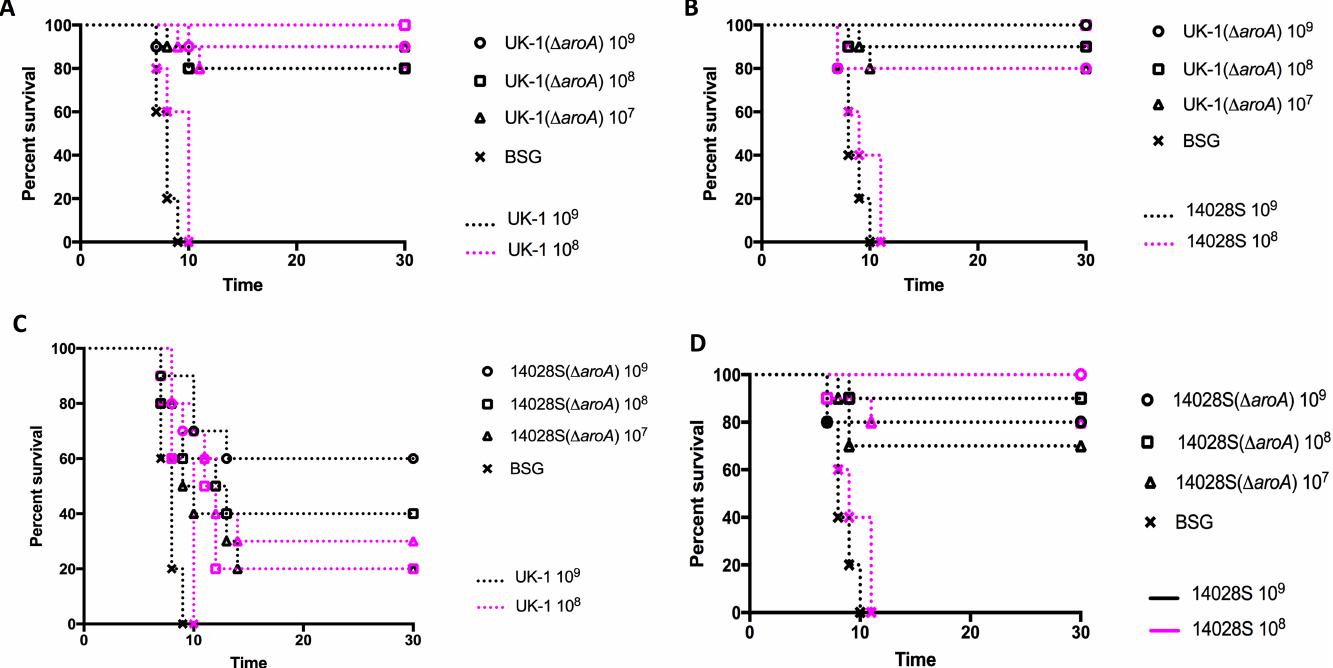
Fig 1. Protective efficacy of Δ aroA mutants UK-1( Δ aroA ) and 14028S( Δ aroA ) against UK-1 and 14028S challenge. BALB/c mice ( n = 10 per immunization dose) were orally immunized with UK-1( Δ aroA ) or 14028S( Δ aroA ) at doses 1x10 9 , 1x10 8 or 1x10 7 CFU in 20 μl BSG. Mice were also mock-vaccinated with 20 μl BSG (n = 5). Oral challenge at doses 1x10 9 or 1x10 8 CFU were performed with UK-1 or 14028S 35 days after immunization. Mice were monitored for mortality and signs of morbidity for 30 days after challenge. Survival curve of (A) UK-1( Δ aroA )-vaccinated UK-1 challenged mice, (B) UK-1( Δ aroA )-vaccinated 14028S challenged mice, (C) 14028S( Δ aroA )-vaccinated UK-1 challenged mice, and (D) 14028S( Δ aroA )-vaccinated 14028S challenged mice. Log-rank (Mantel-Cox) test was used to plot and analyze survival curves.